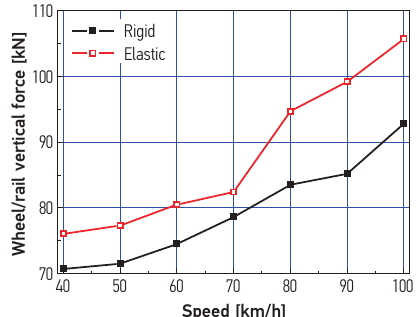
Fig. 9. The wheel / rail absolute maximum vertical force under different